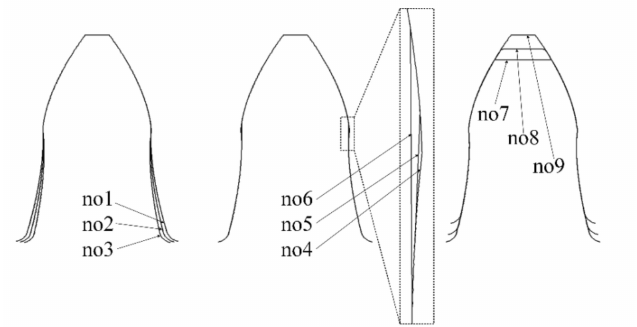
Figure 10. Different tooth profiles of HCR pinion for parametric